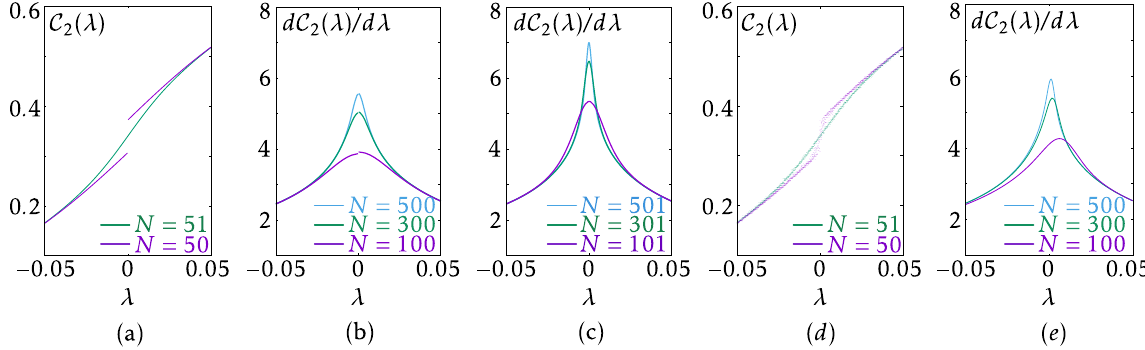
is discontinuous at the critical 2 in the presence of 2